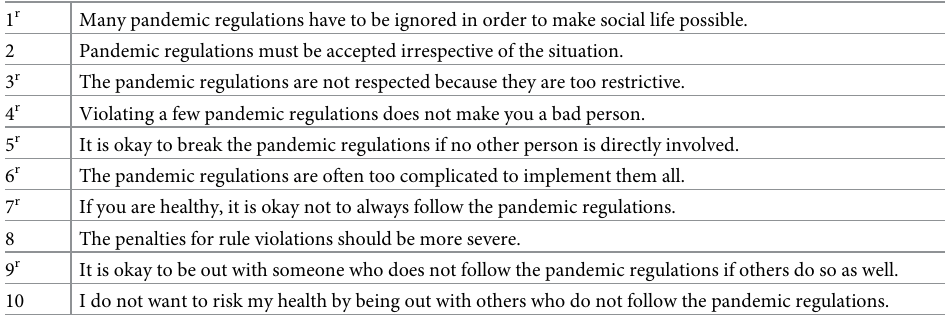
Table 3. Measurement of attitude toward the Covid-19 protection